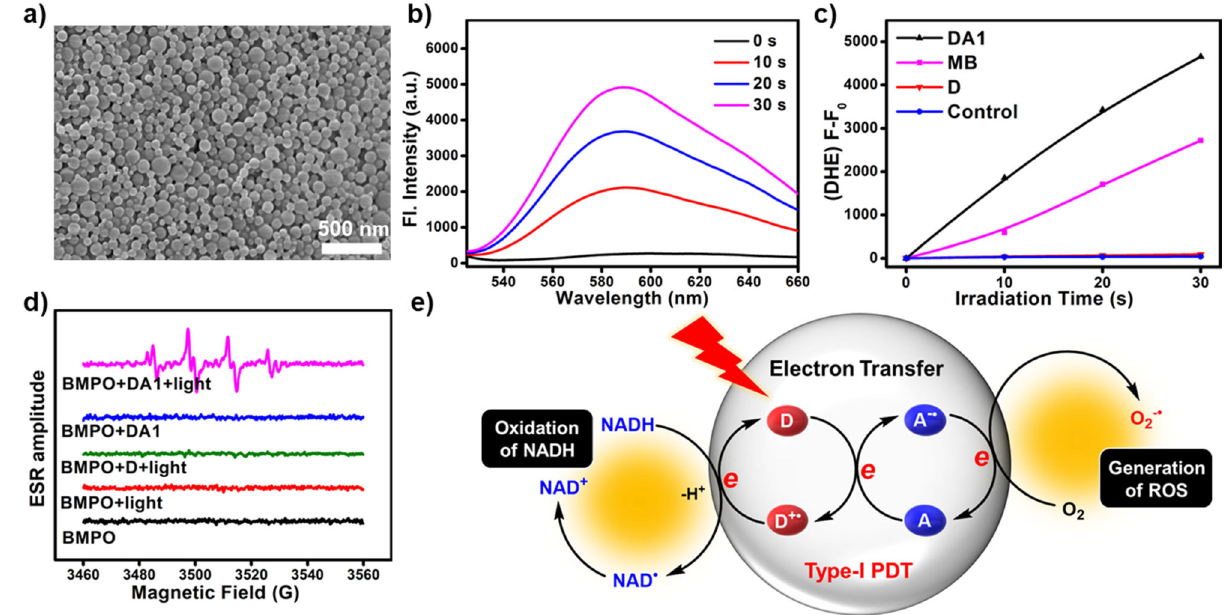
Fig.3|MorphologyandROSgenerationpropertiesofDA1.a SEMimageofDA1. Theexperimentwasrepeatedthreetimesindependently,withsimilarresults.Scale bar: 500nm. b The fl uorescence spectra of DHE (40 μ M, excitation at 510nm, detection from 525 to 660nm) containing 500 μ gmL − 1 ctDNA after irradiation (660nm, 20mWcm − 2 ) for a different time in the presence of DA1 . c Plots of Δ Fl.